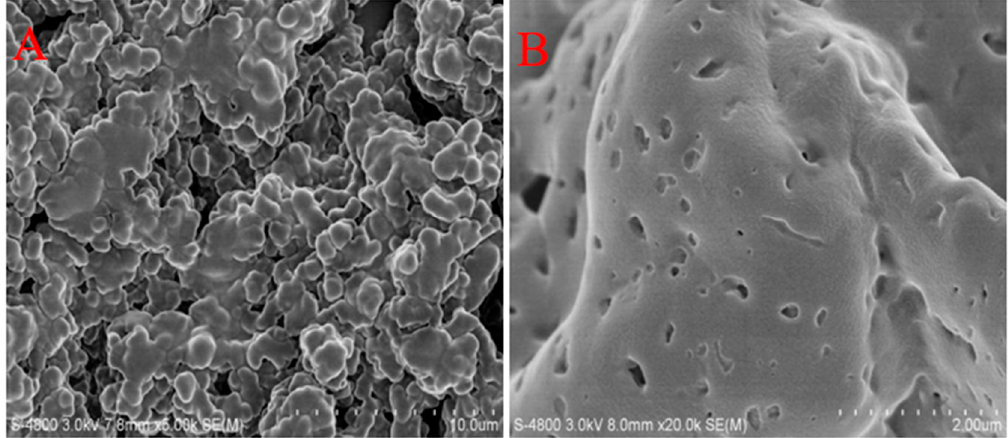
Figure 3. The SEM images of K-CG-TP mixtures (Figure A , B respectively 5K×, 10K×).